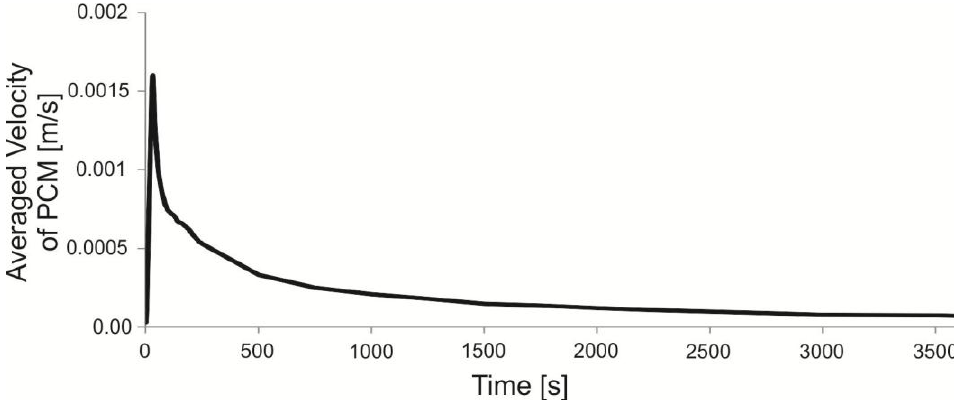
Figure 10. Chronological sequence of the volume averaged velocity during the discharging process.